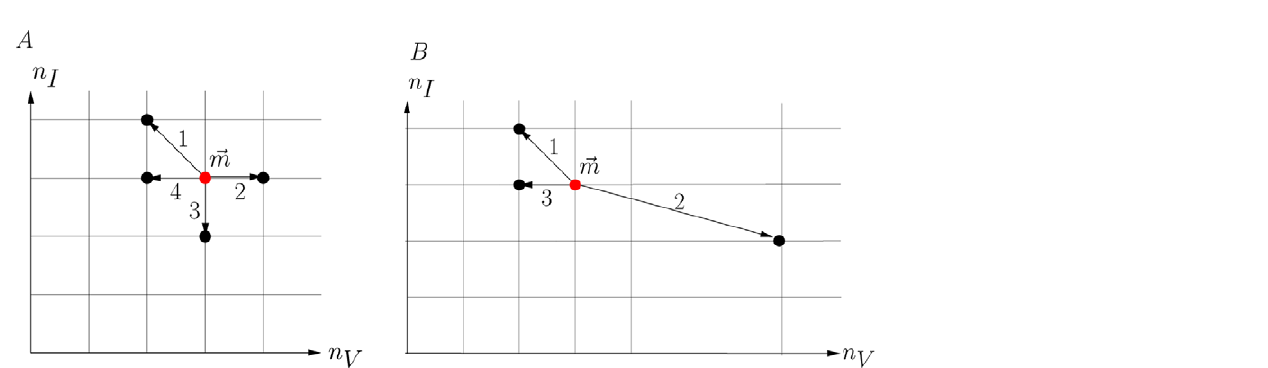
Figure 1. State space diagrams. (A) Continuous production model. Starting from the state ~ mm (the red dot) there are four possible reactions from the point ~ mm ~ ( n V , n I ) to the neighboring points. As stated in the text the possible transitions are ~ mm ? ~ mm z d ~ mm i where d ~ mm 1 ~ ( { 1,1) , d ~ mm 2 ~ (1,0) , d ~ mm 3 ~ (0, { 1) , d ~ mm 4 ~ ( { 1,0) . (B) Burst Model. Starting from the state ~ mm (the red dot) there are three possible reactions from the point ~ mm ~ ( n V , n I ) to the neighboring points. As stated in the text the possible transitions are ~ mm ? ~ mm z d ~ mm i where d ~ mm 1 ~ ( { 1,1) , d ~ mm 2 ~ ( N , { 1) , d ~ mm 3 ~ ( { 1,0) . For both models the i th reaction occurs at rate r i ( ~ mm ) with probability p i ( ~ mm ) ~ r i ( ~ mm ) = S i r i ( ~ mm ) as discussed in the text.